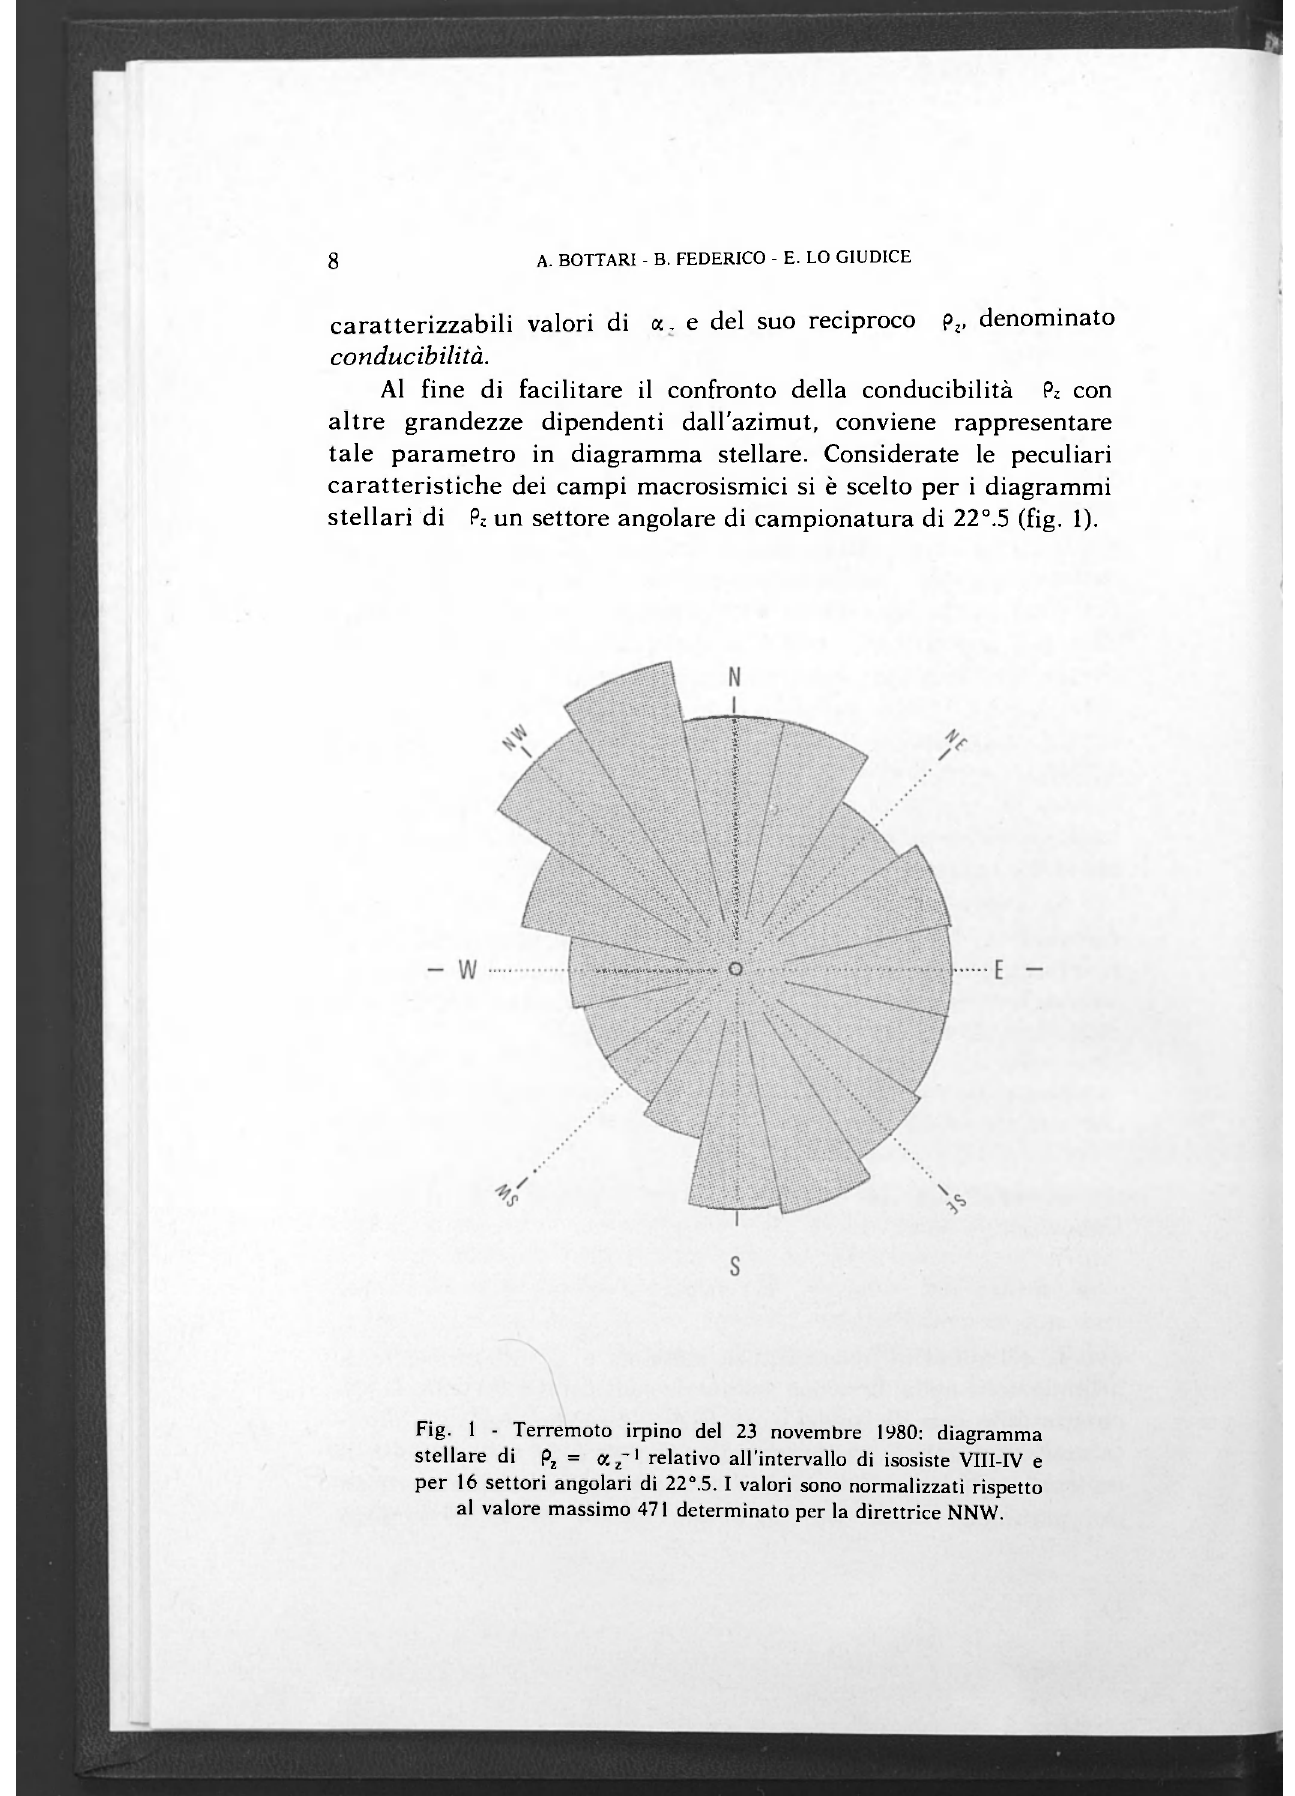
Fig. 1 - Terremoto irpino del 23 novembre 1980: diagramma stellare